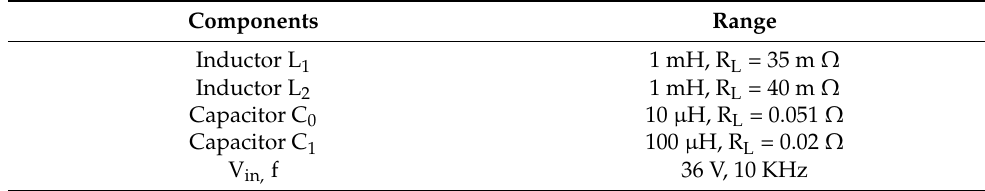
Table 2. The proposed converter’s component specification.